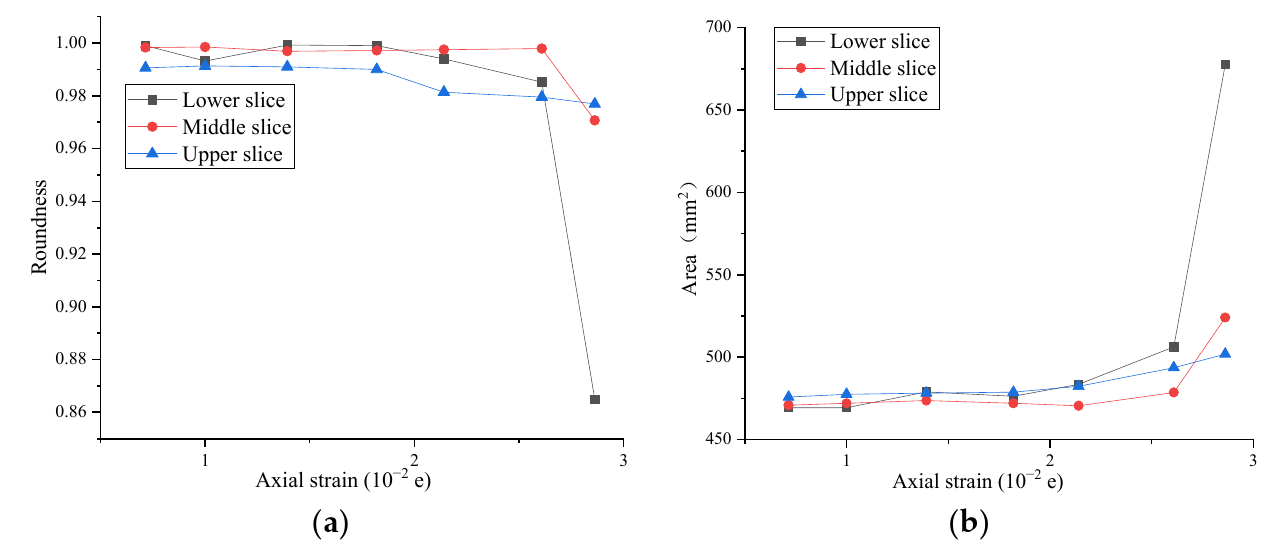
Figure 6. Relationship between axial strain and roundness ( a ) and area ( b ) of CT slice. The calculated roundness was a monotonically decreasing function, and the change in the roundness was generally consistent with the change in the area. The shape and area of each part exhibited a large degree of variation during the instability. The coefficient of variation of the image roundness was calculated to be 0.0473, 0.0097, and 0.0061 for the three slices, that is, the roundness of the lower slice was significantly larger than those of the middle and upper slices. The anisotropy of the deformation and failure features of the sample were very pronounced at the macroscopic scale.